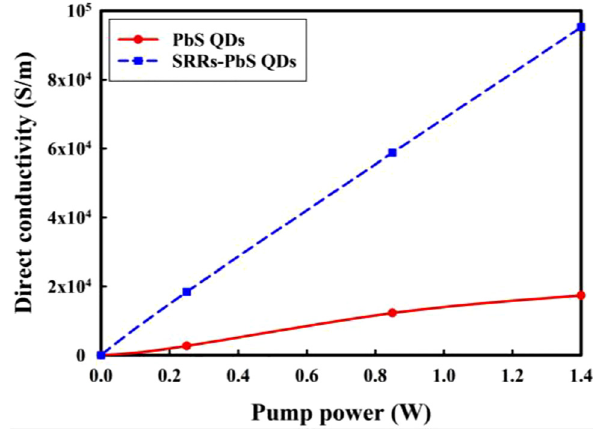
Figure 6: PumppowerdependentdcconductivityobtainedfromEq.(5).